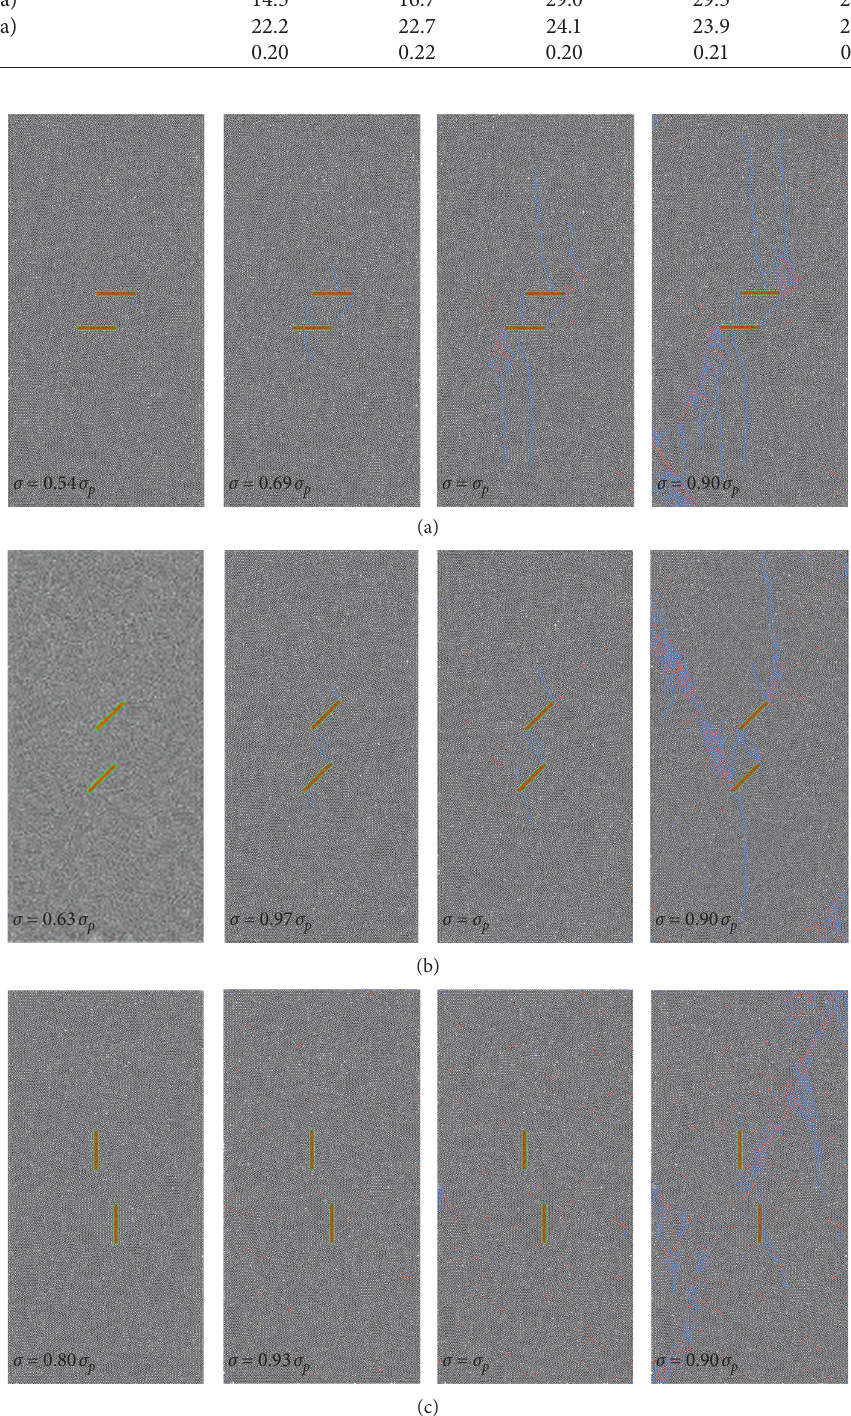
Figure 12: Crack development process of samples containing infilled flaws with the same β of 120 ° and different α of 0 ° , 45 ° , and 90 ° (blue cracks represent tensile cracks and red cracks represent shear cracks). (a) α � 0 ° and β � 120 ° , (b) α � 45 ° and β � 120 ° , (c) α � 90 ° and β � 120 °